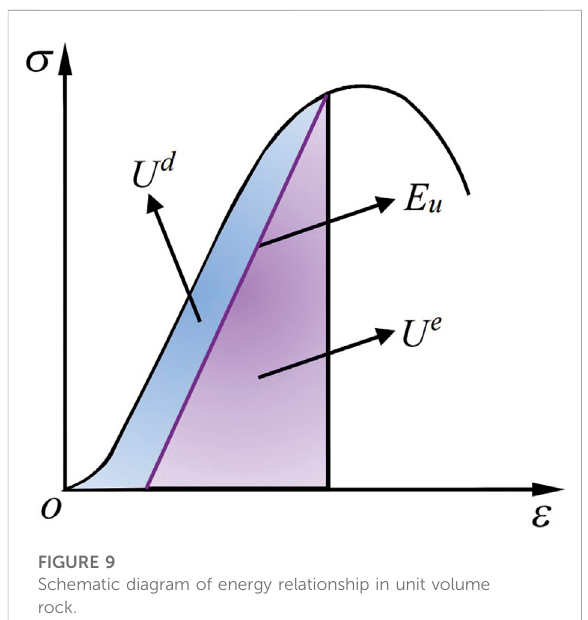
FIGURE 9 Schematic diagram of energy relationship in unit volume